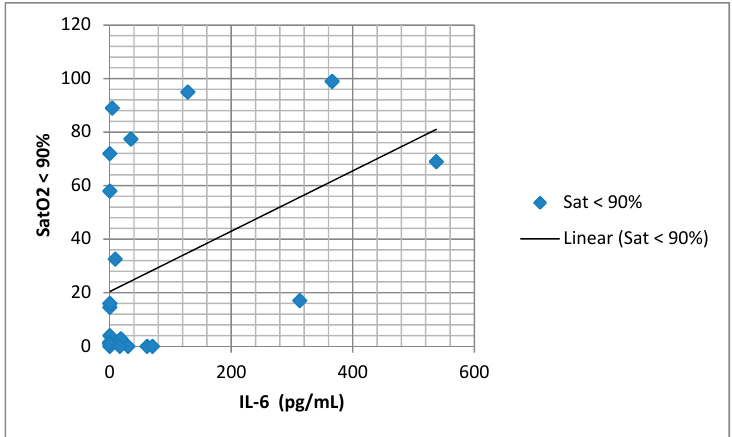
Figure 3. Correlation of serum CRP and body fat percentage (FM%) ( r = 0.450, p = 0.024) .